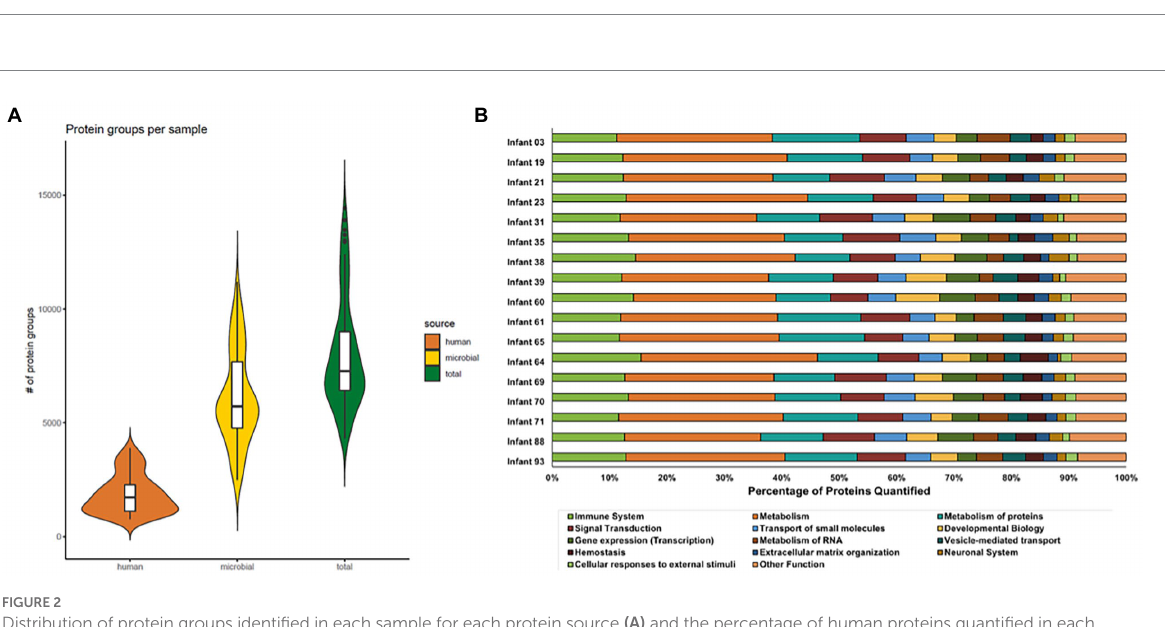
to pseudo-replication. This analysis showed that time (day of life or gestational age) was the primary factor influencing the functional β -diversity of samples for each infant (value of p <0.01).